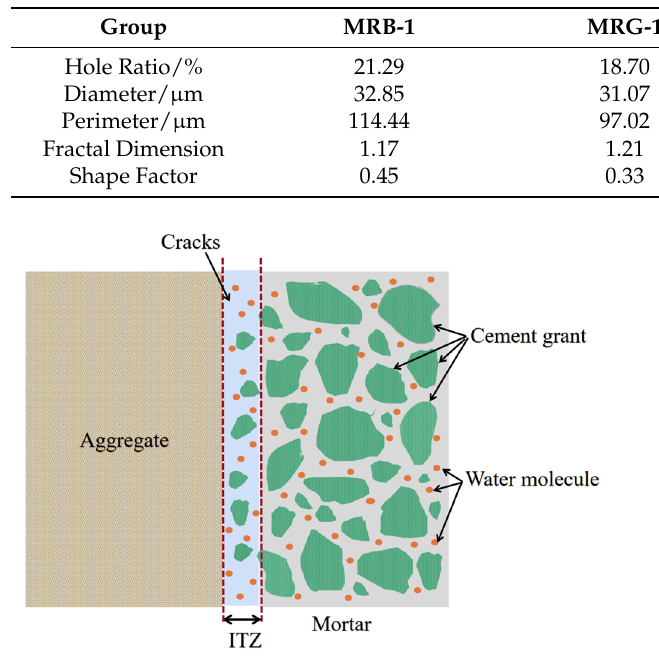
Table 8. ITZ microanalysis parameter statistics.